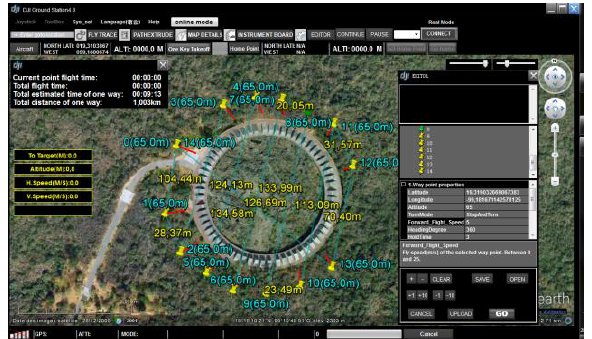
Figure 3. Ground Station’s flight plan